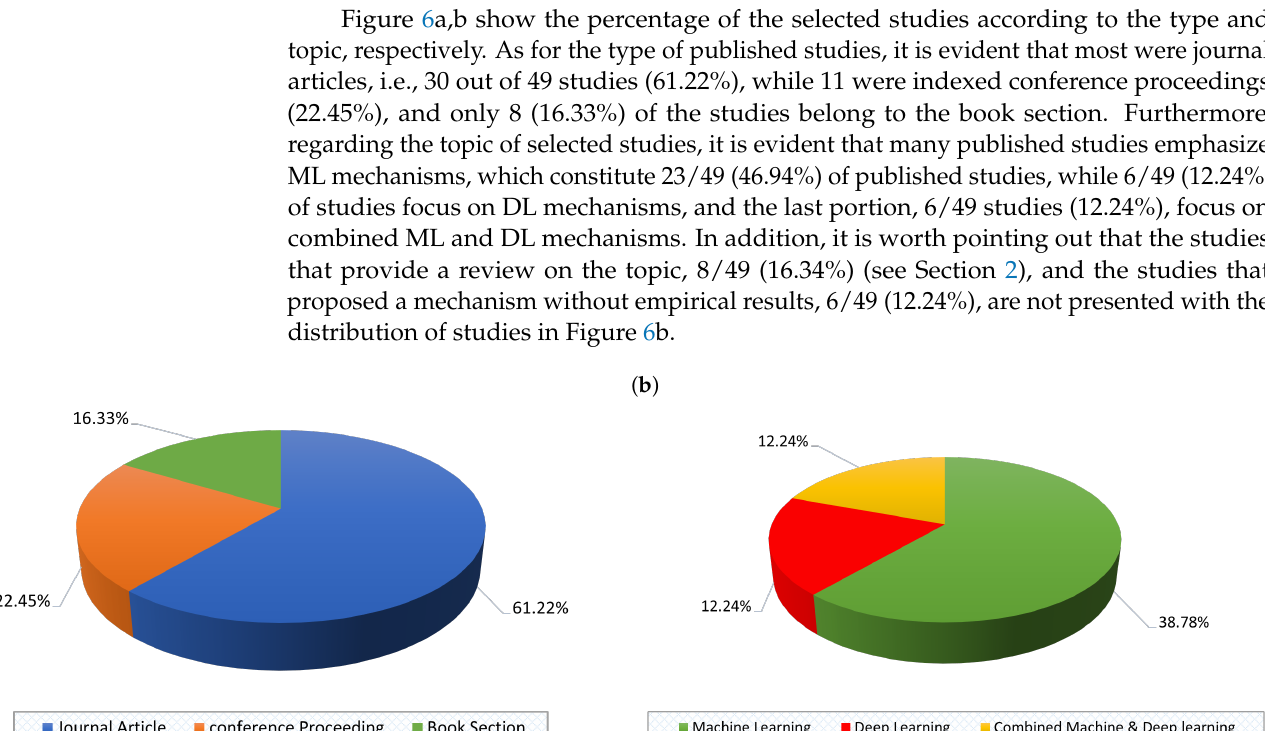
Figure 5. Distribution of selected studies according to ( a ) Year of Publication, ( b ) Digital Libraries.